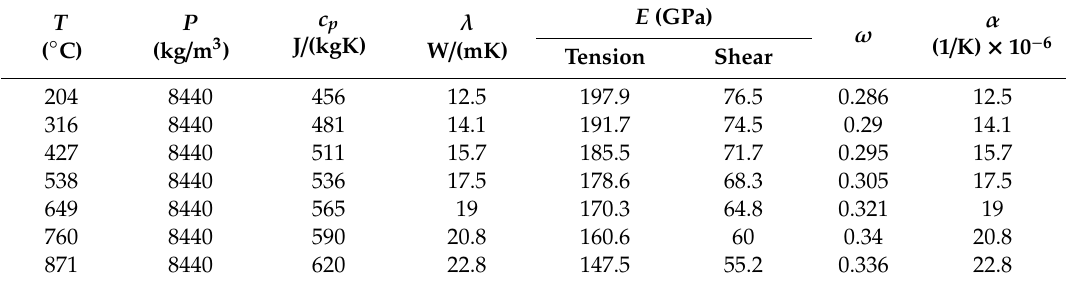
Table 5. Properties of the solid (INCONEL 625)